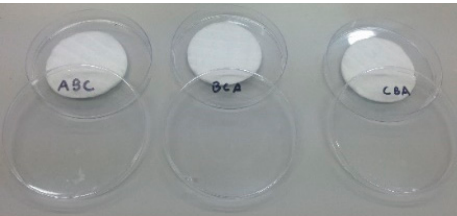
Figure 4. Samples of the fragrances developed for the 2nd tasting session, in the respective Petri dishes.